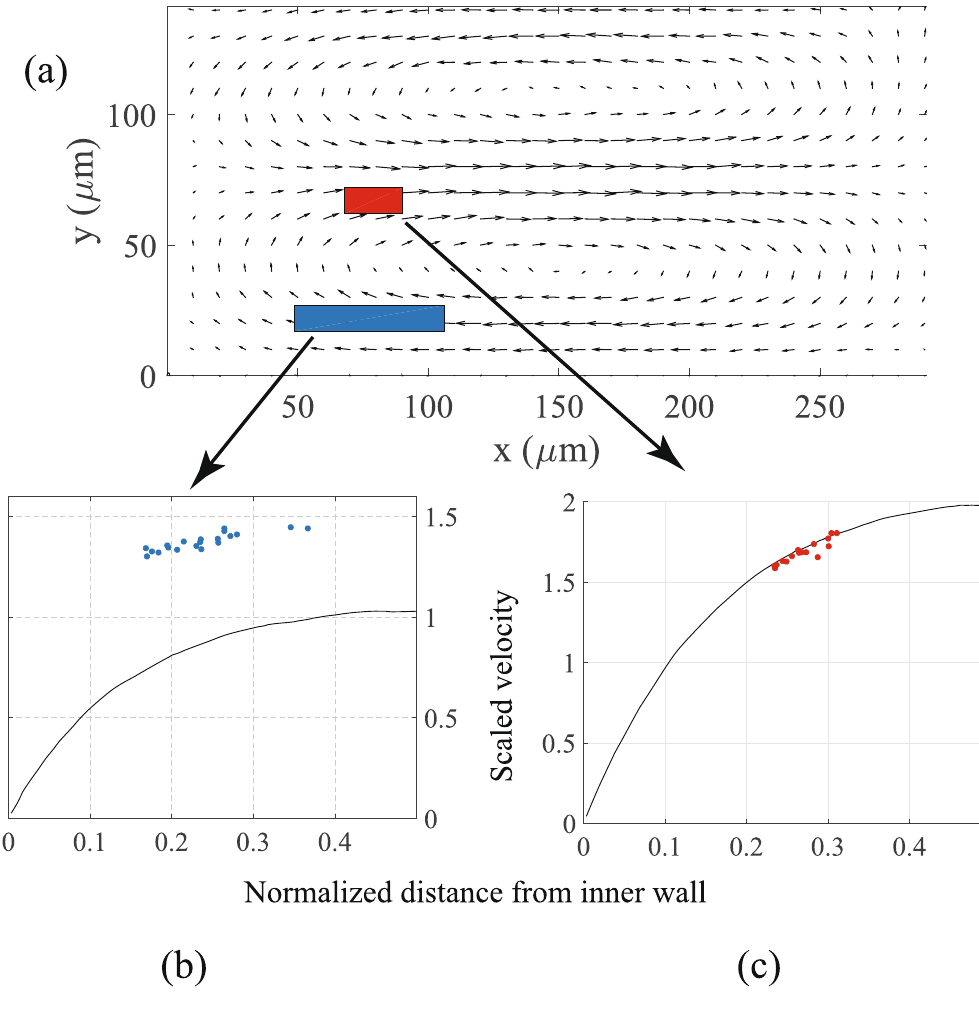
Figure 3. ( a ) Positions of focusing windows in the cross section with the Dean vortices. The inner wall is at x = 0 and the bottom of the channel is at y = 0. ( b ) and ( c ) The velocities of the particles in the two focusing windows, with the black curve showing the velocity of the